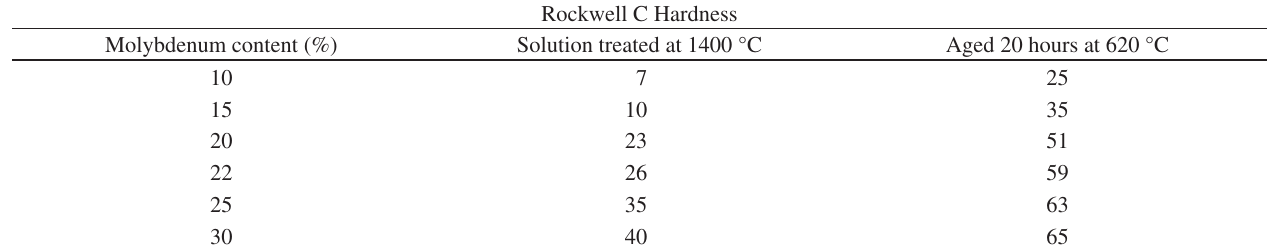
Table 1. Values of hardness for alloys with different concentrations of Mo.